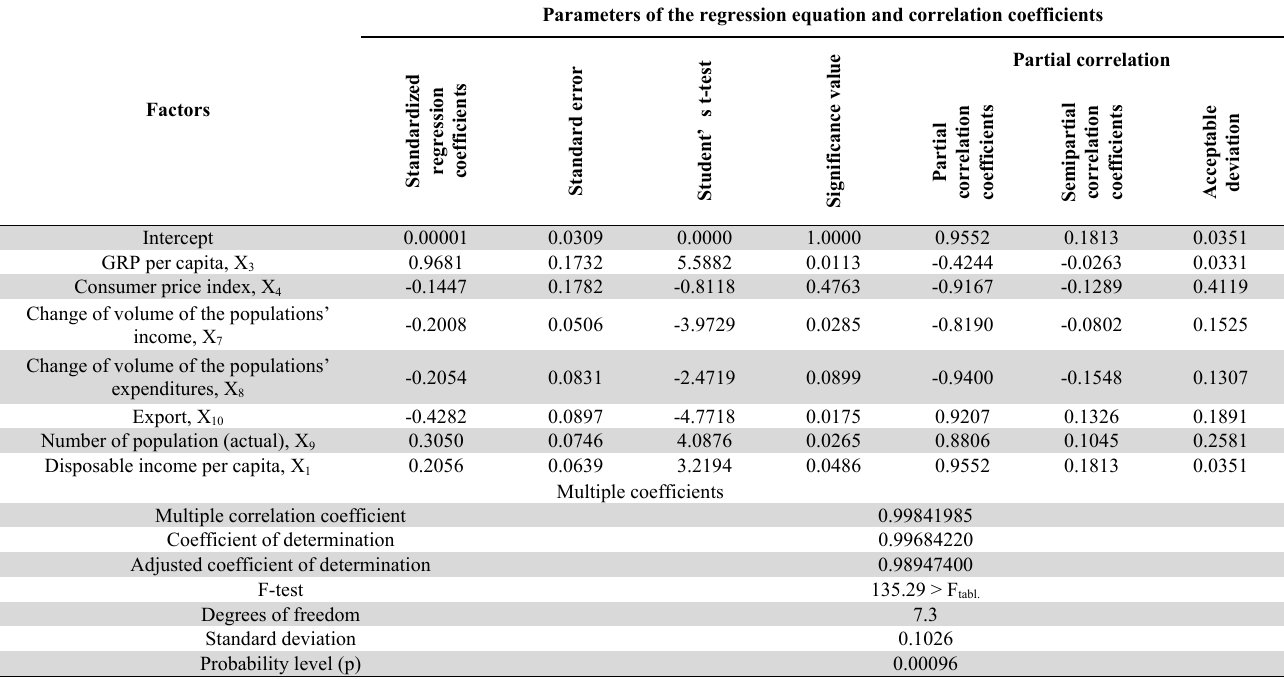
Results of multiple regression of the dependence between the volume of sold food products in Ivano-Frankivska oblast and socio- economic factors (estimation by stepwise regression with F-test)